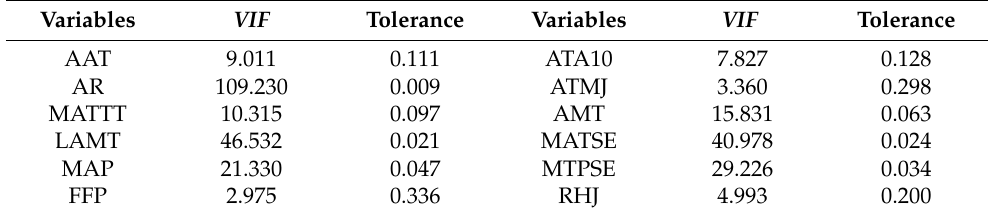
Table 3. Diagnosis of covariance between different meteorological